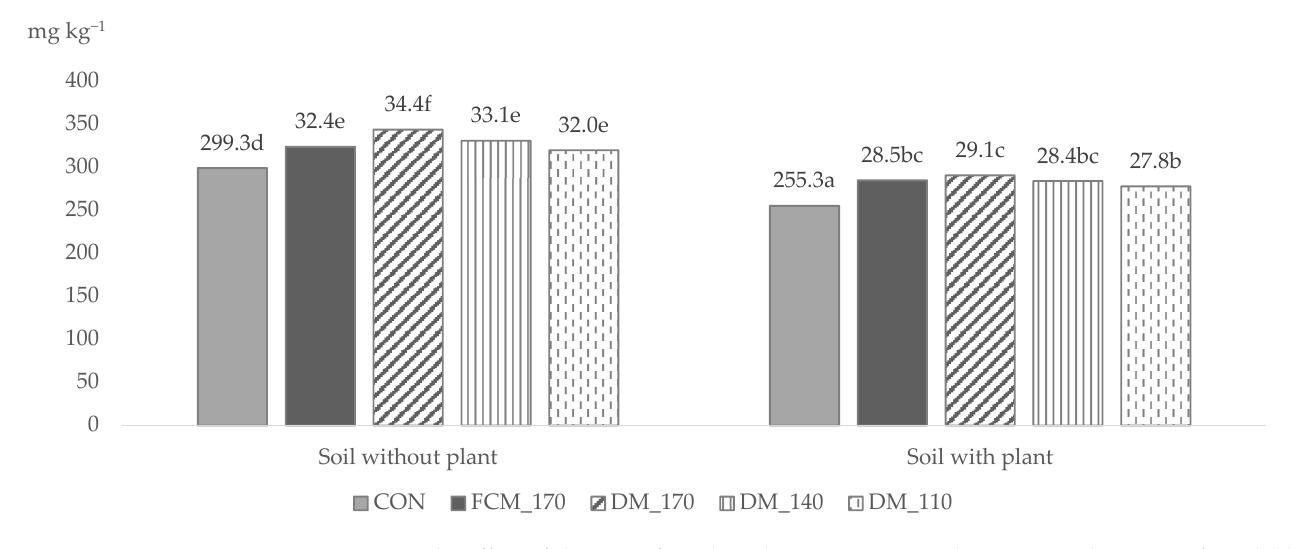
Figure 2. The effect of digestate from liquid cow manure on changes in soil content of available